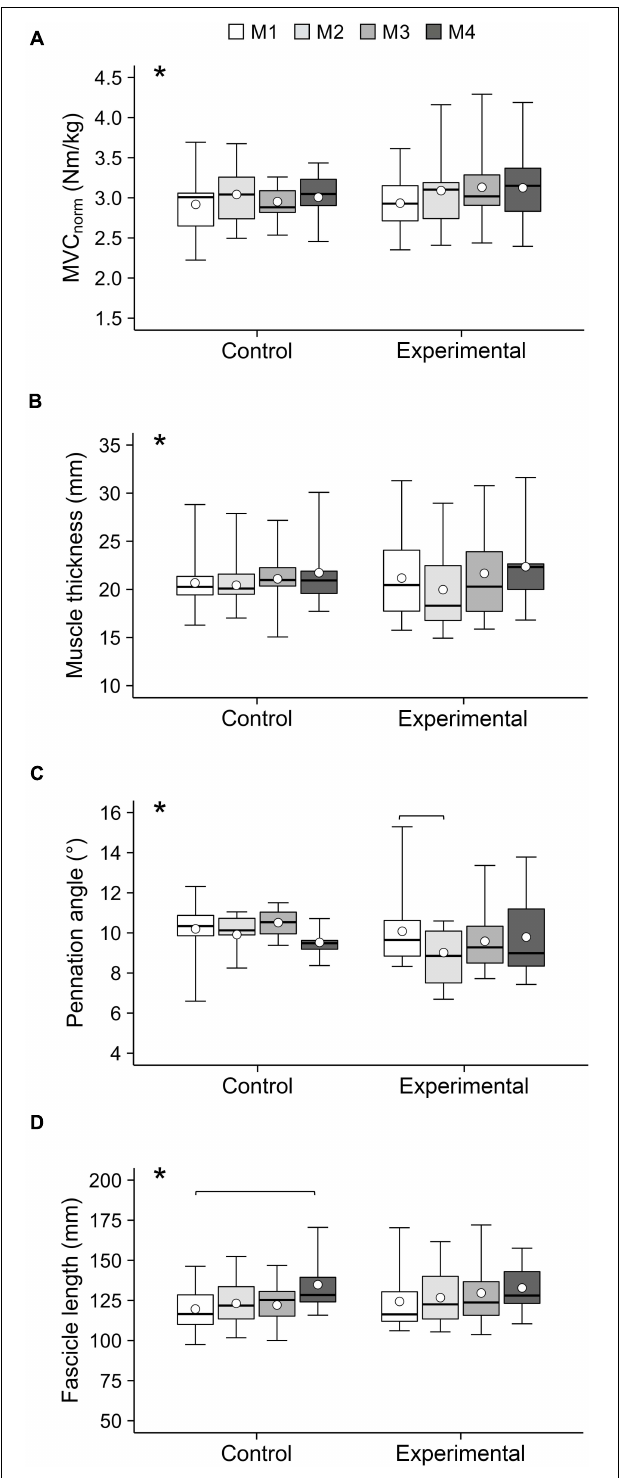
FIGURE 3 | (A) Maximum isometric knee extension moment normalized to body mass (MVC norm ), (B) vastus lateralis muscle thickness, (C) pennation angle and (D) fascicle length of the adolescent handball athletes in the control and experimental group at the four measurement time points (M1–M4) over